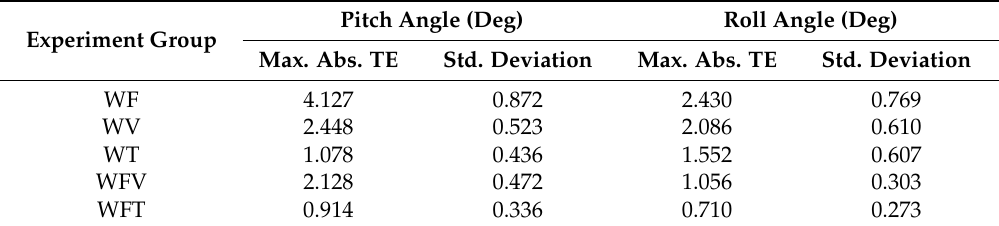
Table 6. The attitude regulation results of different control schemes.